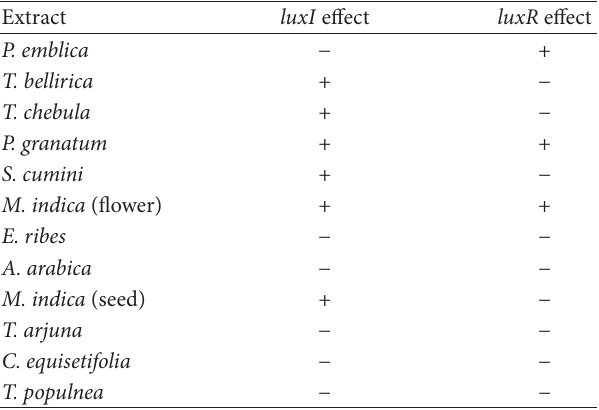
Table 2: Demonstration of luxI / luxR effect by plant extracts.